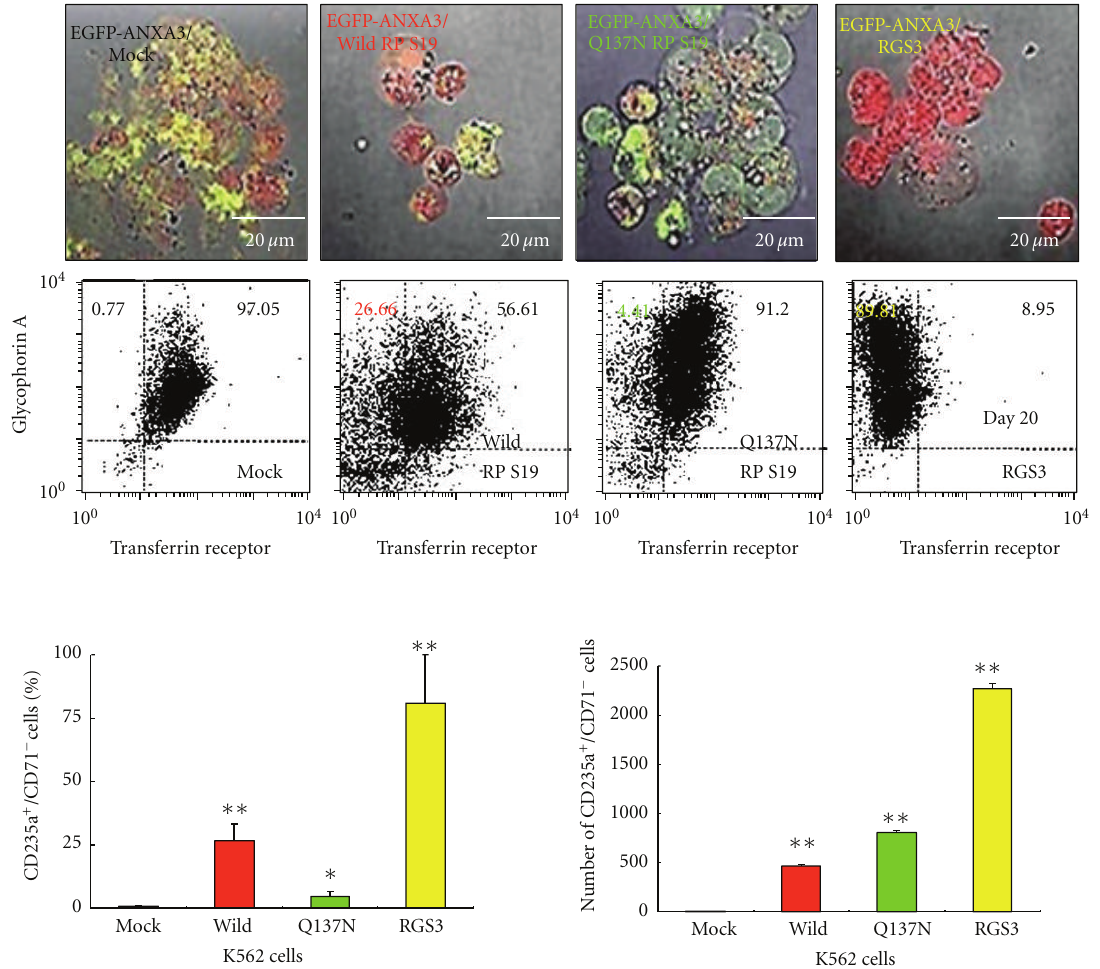
Figure 4: Contribution of the C5aR-RP S19 oligomer system to the haemin-induced terminal di ff erentiation of K562 cells under monocell culture conditions. K562 cells expressing EGFP-ANXA3/Mock, EGFP-ANXA3/Wild-type RP S19, EGFP-ANXA3/Q137N mutant RP S19, and EGFP-ANXA3/RGS3 were harvested at several time points after the haemin induction and analysed under CLSM ( n = 3). The mock (black), Wild-type RP S19 (red), Q137N mutant RP S19 (green), and RGS3 (yellow) K562 cells were harvested at several time points after the haemin induction and stained with FITC-conjugated anti-CD71 and APC-conjugated anti-CD235a mouse IgGs for FACS analyses ( n = 3). The averages of the percentage and number of CD235a + /CD71 − erythrocyte-like cells were calculated on day 20 of the monocell culturing. P values of less than 0.05 were considered statistically significant ( ∗ P < 0 . 05 or ∗∗ P < 0 .